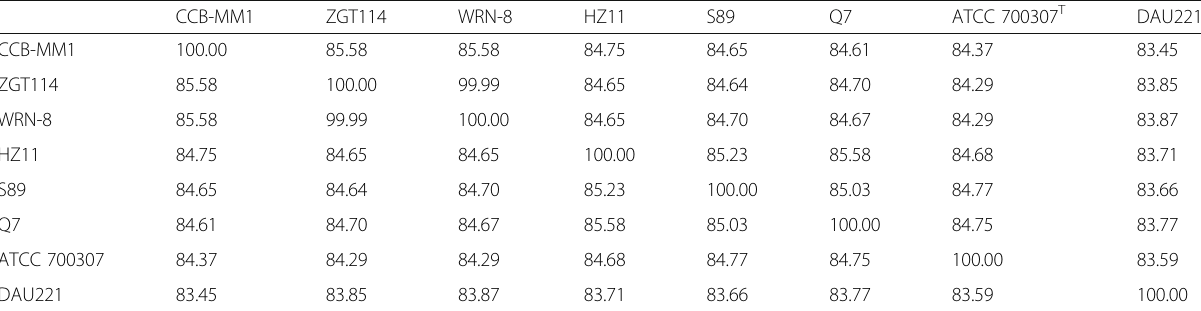
Table 5 ANI value(%) between Microbulbifer sp. CCB-MM1 genome and seven other Microbulbifer genomes calculated using ANIm